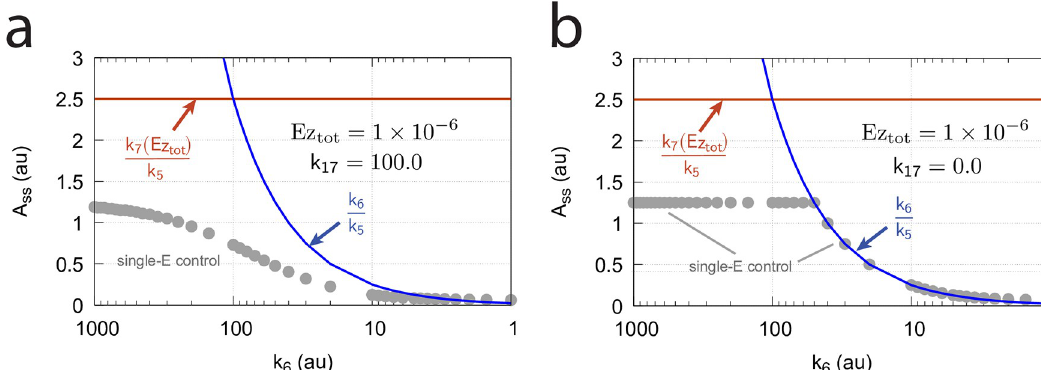
Fig 50. A ss (= A set ) as a function of k 6 when (a) k 17 =100.0 and (b) k 17 = 0.0. Gray solid points show the numerically calculated values , while red and blue curves show the values of k 7 ( Ez )/ k 5 and k 6 / k 5 , respectively. Other rate constant values: k 1 =800.0, k 2 =1.0, of A ss tot k 3 =0.0, k 4 =1.0, k 5 =40.0, k 7 =1 × 10 8 , k 9 = k 11 = k 13 =1 × 10 8 , and k 10 = k 12 = k 14 =1 × 10 3 . Initial concentrations: A 0 =1.0, E 1,0 =9.9 × 10 1 , =3.97 × 10 − 7 . Simulation time: 3000 time units, E 2,0 =5.04 × 10 − 1 , Ez 0 =6.03 × 10 − 9 , (E 2 � Ez) 0 =4.97 × 10 − 7 , (Ez � � E 1 ) 0 =1.0 × 10 − 7 , and Ez � 0 step-length: 0.01 time units.